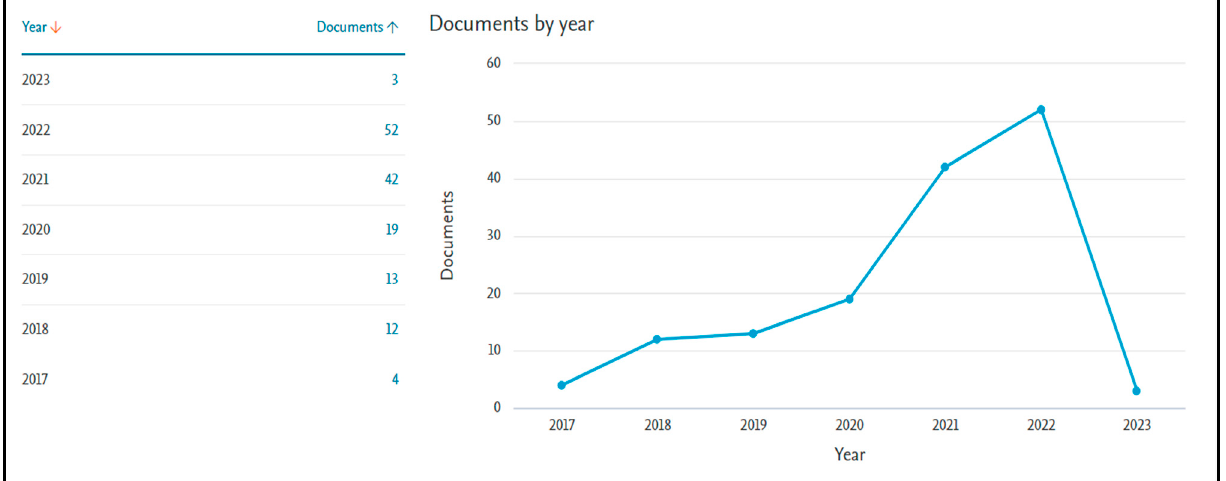
Figure 1. Annual documents published.